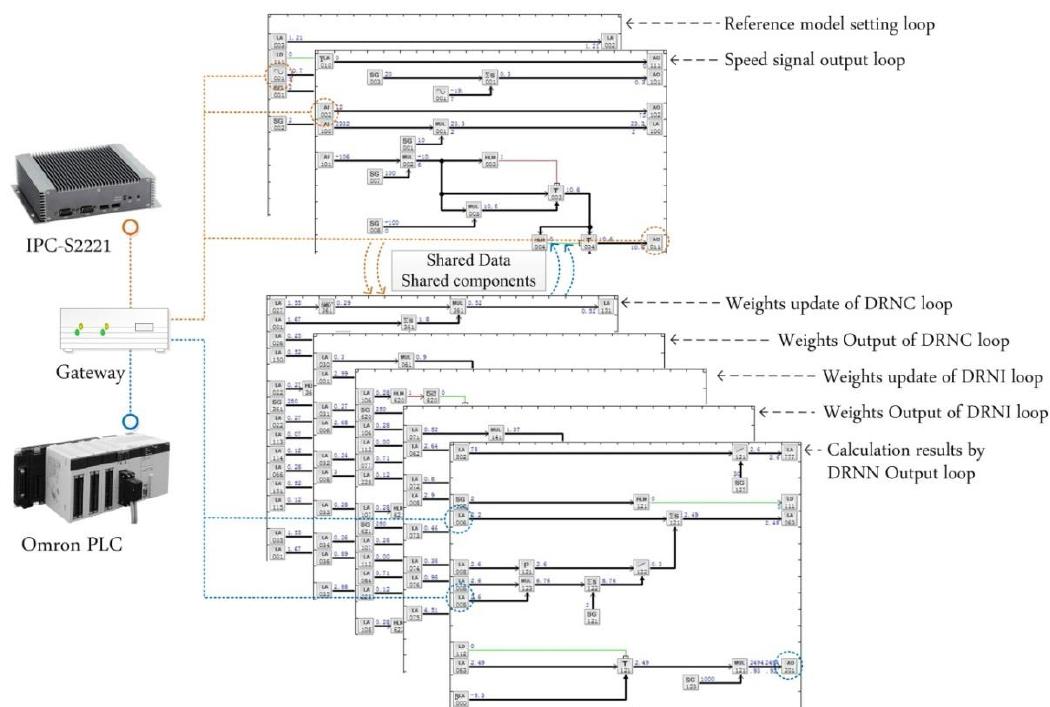
Figure 12. Collaborative control configuration diagram of different hardware devices.